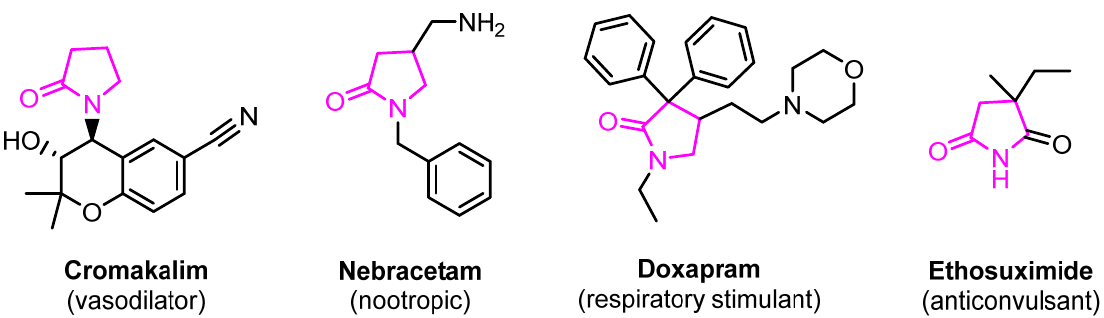
Figure 1. Pharmaceuticals with 2-pyrrolidinone scaffold.